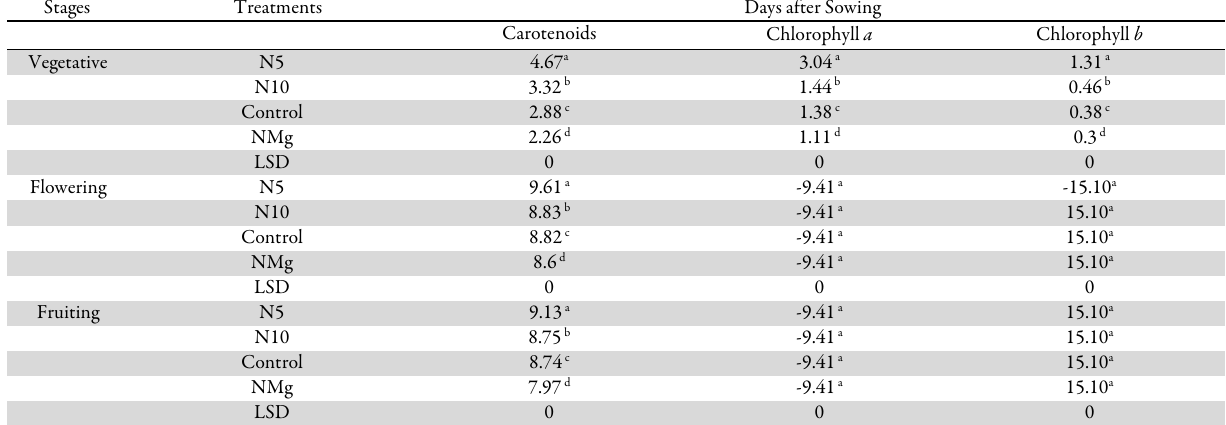
Table 2. The effect of Magnesium application at vegetative stage of the photosynthetic pigment accumulation of C. olitorius Stages